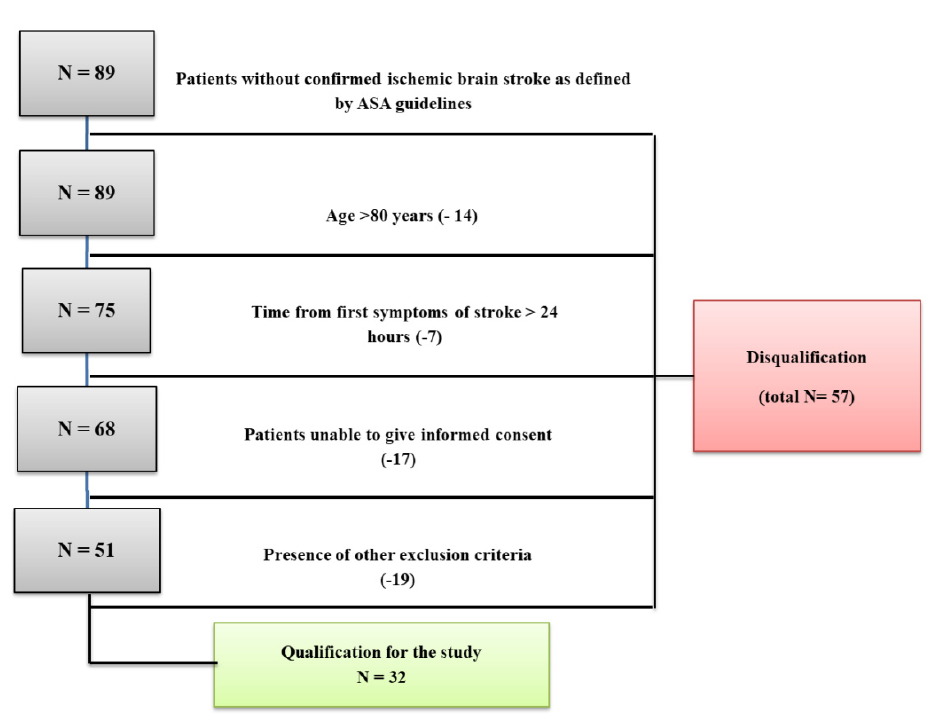
Figure 1. A flow chart presenting the recruitment of the subjects.